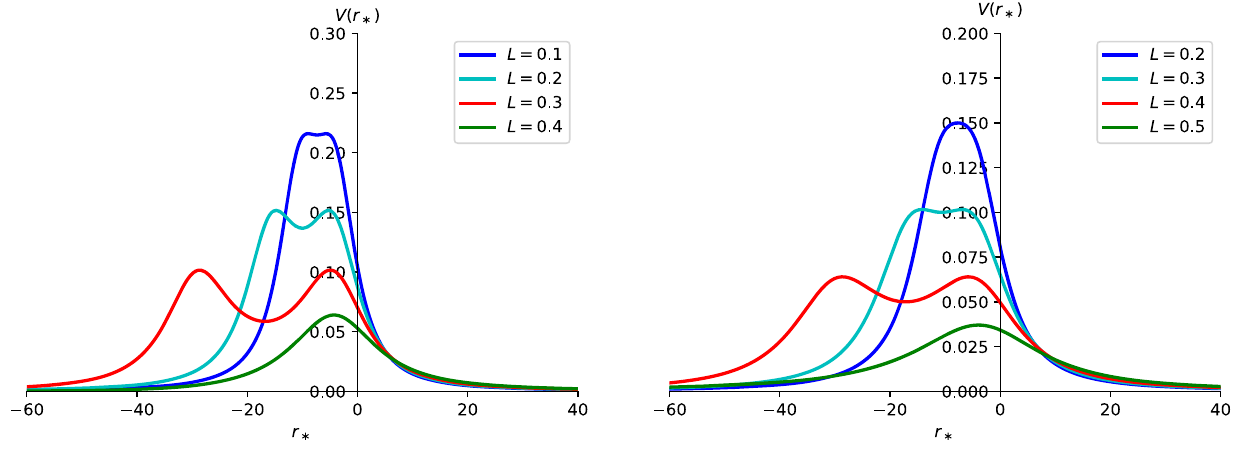
Fig. 3 The effective potential of the electromagnetic field perturbation for different L with M = 0 . 5 , l = 1, a = 1 . 6 (left) and a = 2